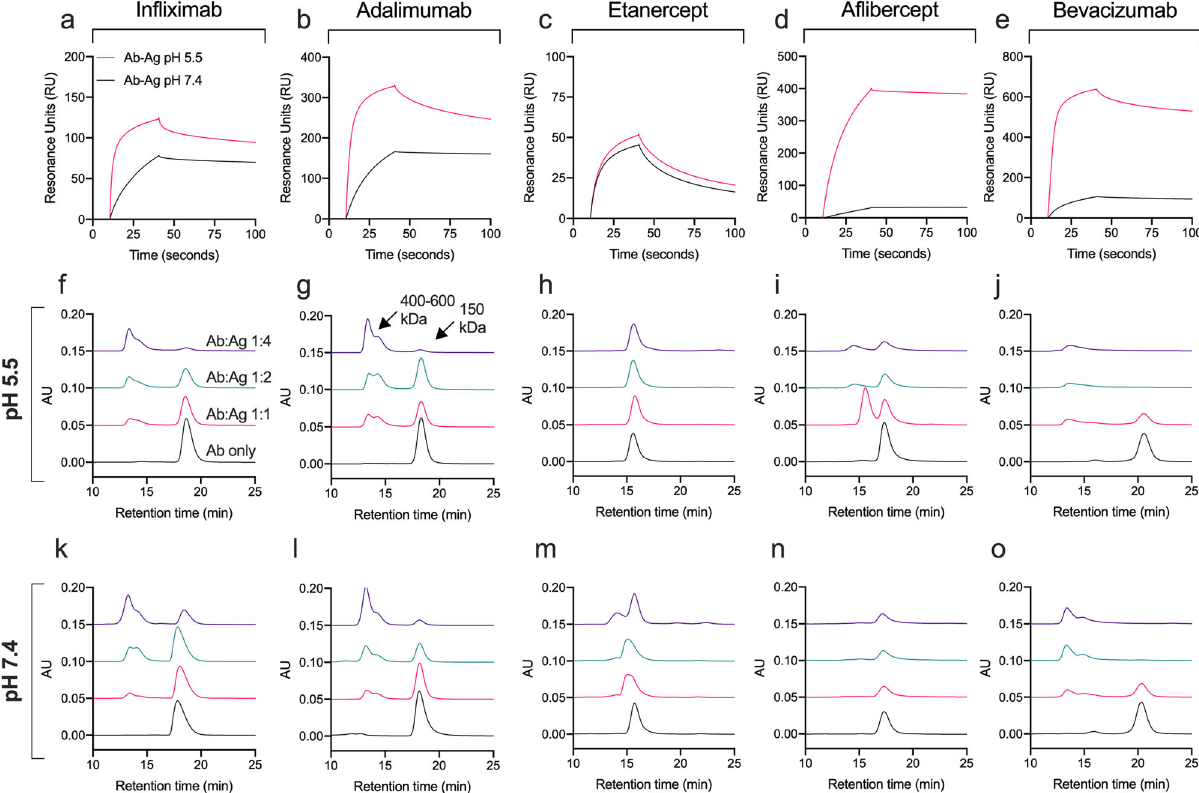
Fig. 4 Ag-binding and immune complex formation are affected by pH and differ between IgG1s and Fc-fusions. a – e SPR sensorgrams showing ABTs (100 nM) injected over and binding to immobilized cognate Ags (~300 RU) at either pH 5.5 or 7.4. Analytical SEC of ABTs preincubated with increasing amounts of their cognate Ag at either ( f – j ) pH 5.5 or ( k – o ) 7.4 before injection. Color labeling a – d ; Ab-Ag injected at pH 5.5 (red) and at pH 7.4 (black). Color labeling f – o ; Ab only (black), Ab:Ag 1:1 (red), Ab:Ag 1:2 (teal), Ab:Ag 1:4 (dark